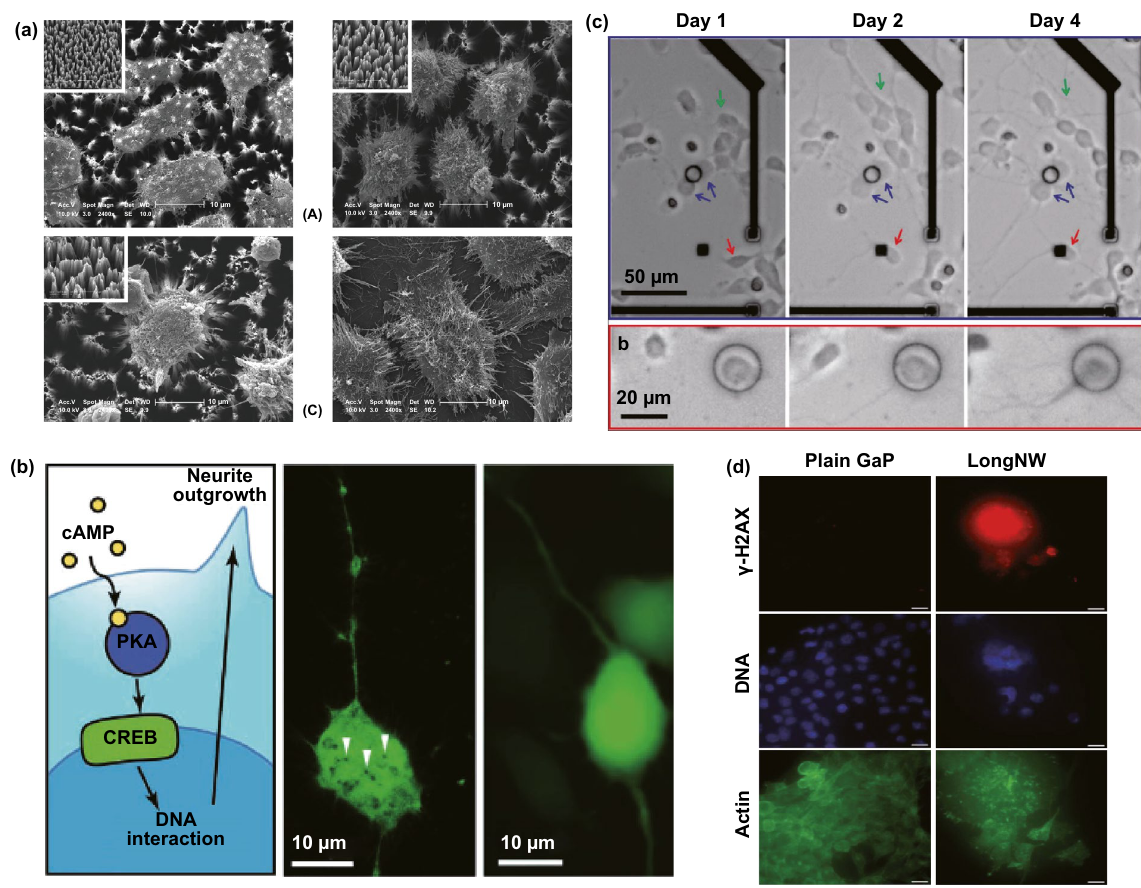
Fig. 4 a Morphology and diffusion of cultured hepatic cells on Si NW arrays with different NW density. Scale bar: 10 µm [110]. b Matura‑ tion of neurons on InAs NW array [108]. c The migration of cortical neurons is followed at 1, 2 and 4 days after plating [111]. d γ‑H2AX assay to study DNA double‑strand breaks [112]. Reproduced with permission from Refs. [108, 110–112], copyright (2011) Wiley–VCH Publishing Group. (2009) American Chemical Society Publishing Group (2010) American Chemical Society Publishing Group and (2013) Wiley‑VCH Publishing